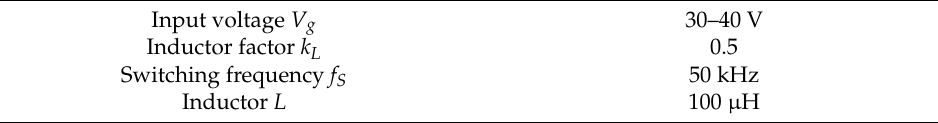
Table 7. Parameter values of the voltage-doubler boost converter.